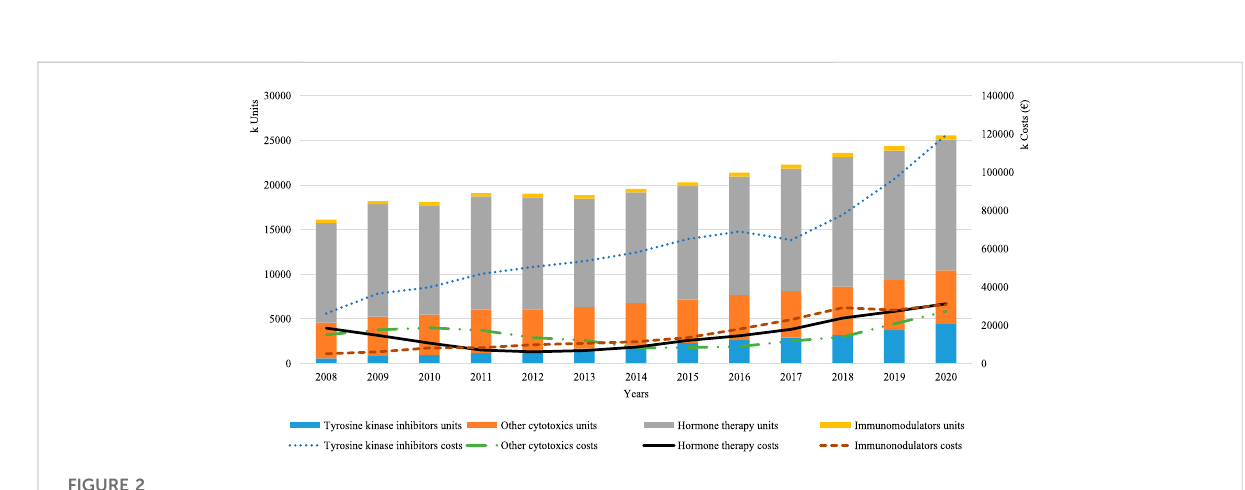
FIGURE 2 Overall consumption per pharmacotherapeutic